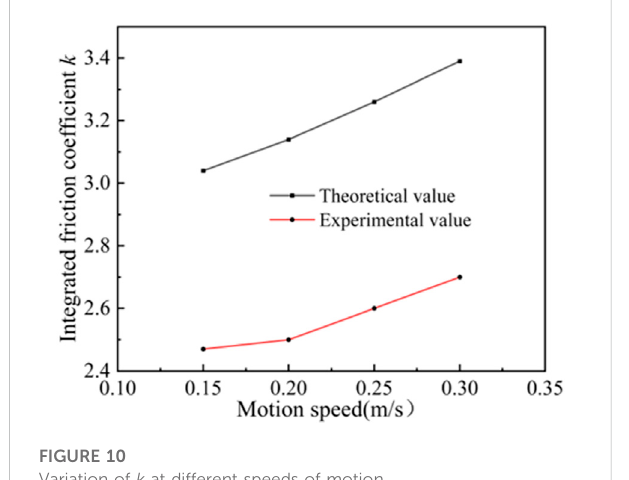
FIGURE 12 Comparison of theoretical and experimental values of the maximum restoration